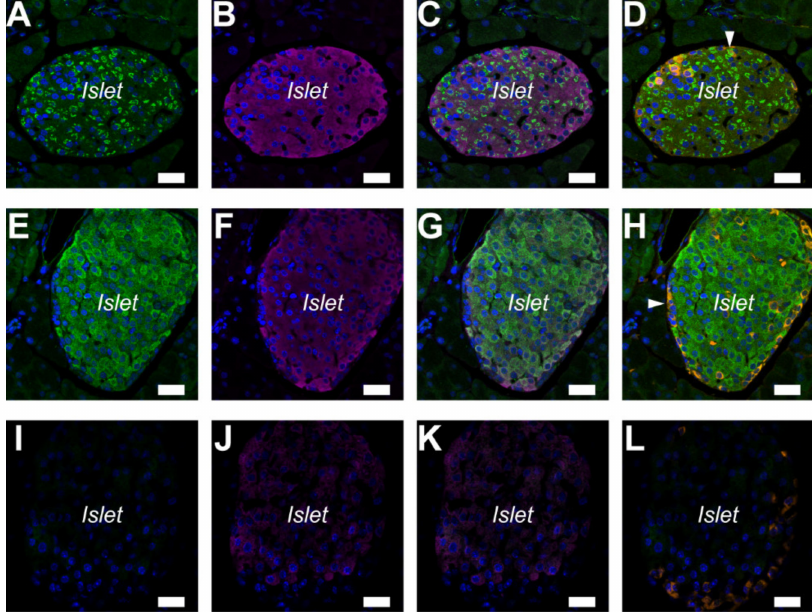
Figure 2. Immunolocalization of A 2A and A 2B adenosine receptors in pancreatic islets of the mouse. ( A ) Fluorescence of A 2A adenosine receptor inside cells. ( B ) Fluorescence image of insulin. ( C ) Overlay image of A and B . ( D ) Overlay of A and fluorescence image of glucagon (orange) in the same sample. A few glucagon-positive α -cells expressed A 2A adenosine receptors (arrowhead). ( E ) Fluorescence of A 2B adenosine receptor in cells. ( F ) Fluorescence image of insulin. ( G ) Overlay image of E and F . ( H ) Overlay of E and fluorescence image of glucagon ( orange ). Glucagon-positive α -cells did not express A 2B adenosine receptors (arrowhead). ( I ) Isotype control image of the mouse pancreas with normal rabbit IgG (2 µ g / mL). ( J ) Fluorescence image of insulin. ( K ) Overlay image of I and J . ( L ) Overlay of I and fluorescence image of glucagon (orange). DAPI was used to stain nuclei (blue). Representative images of three mice are shown. Bars = 20 µ